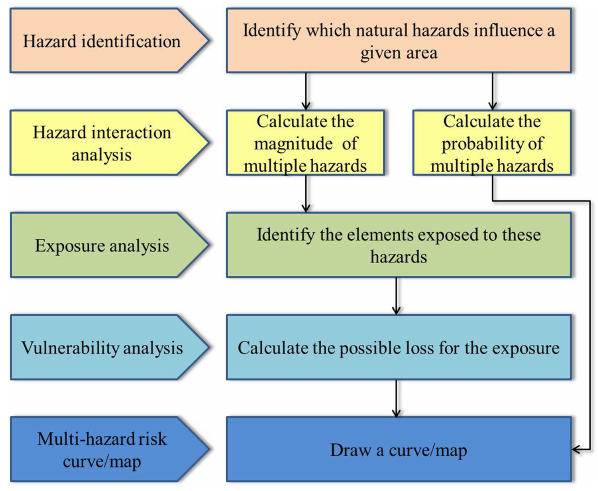
Figure 1. Basic framework of multi-hazard risk